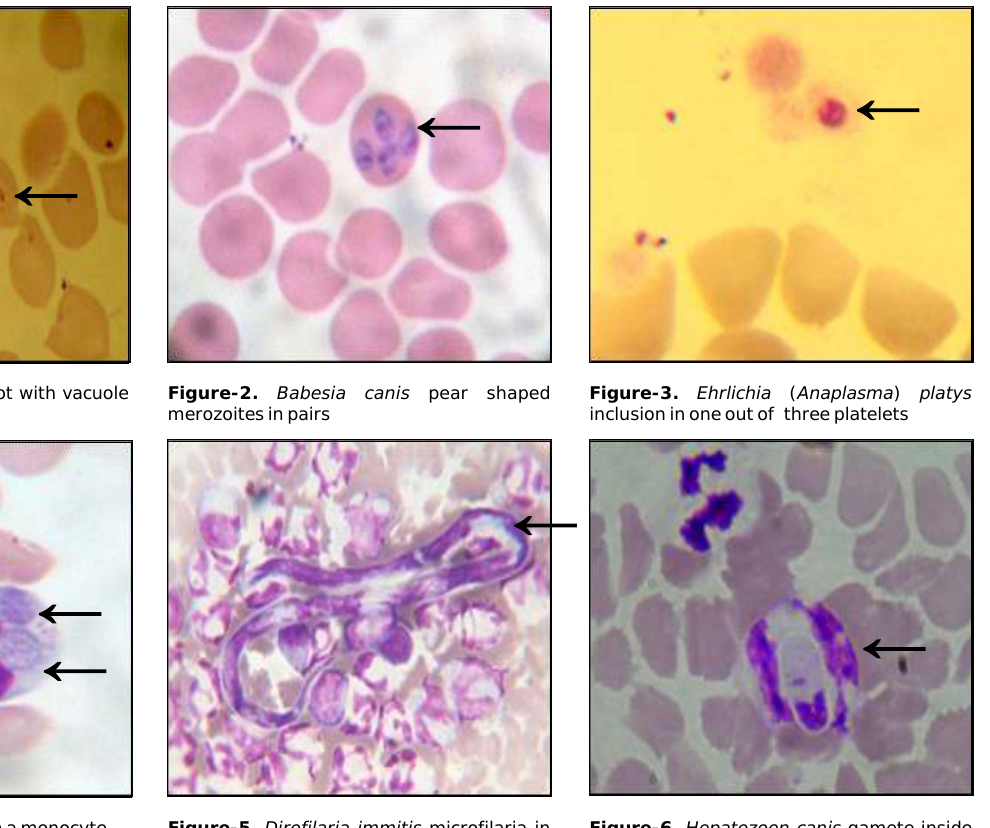
Figure-6. Hepatozoon canis gamete inside